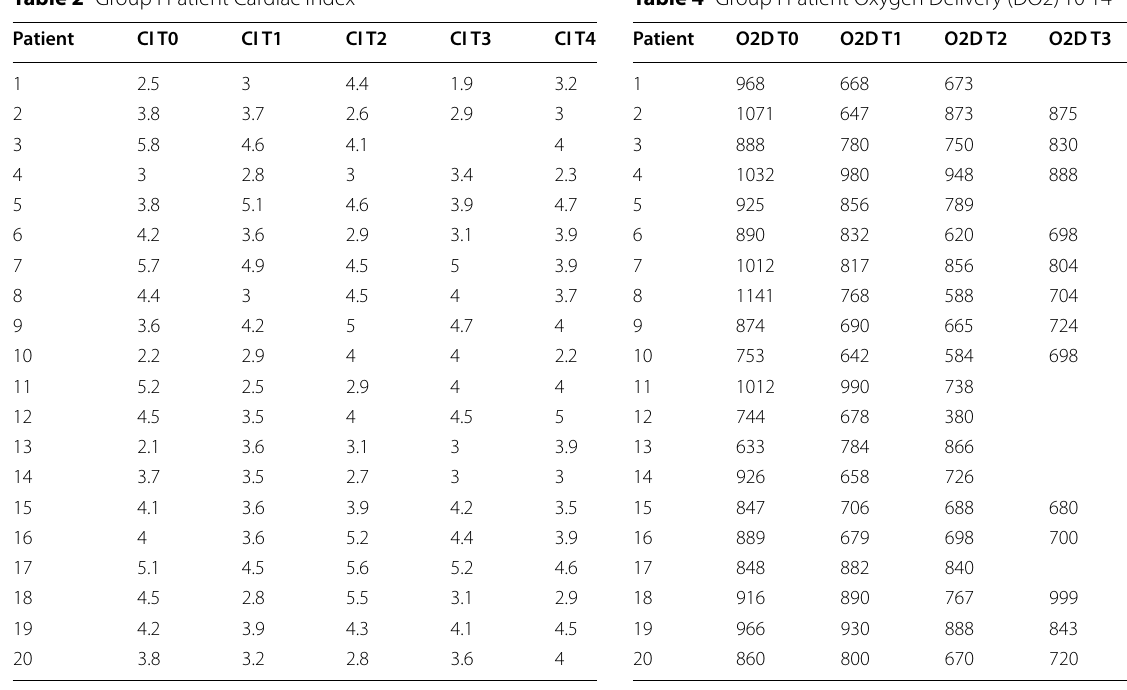
Table 2 Group I Patient Cardiac Index